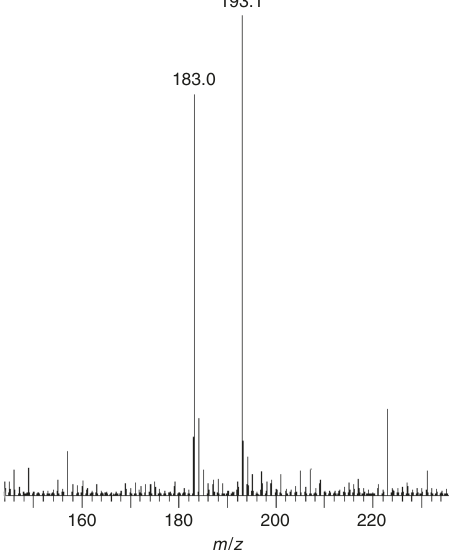
Fig. 7 Positive-ion mode electrospray ionisation mass spectrometry of the azobenzene product obtained from the reductive elimination of 3 . The signals at m/z 183.0 and 193.1 con fi rm the presence of exclusively H 10 – PhNNPh and D 10 – PhNNPh, respectively, with no H 5 /D 5 – PhNNPh